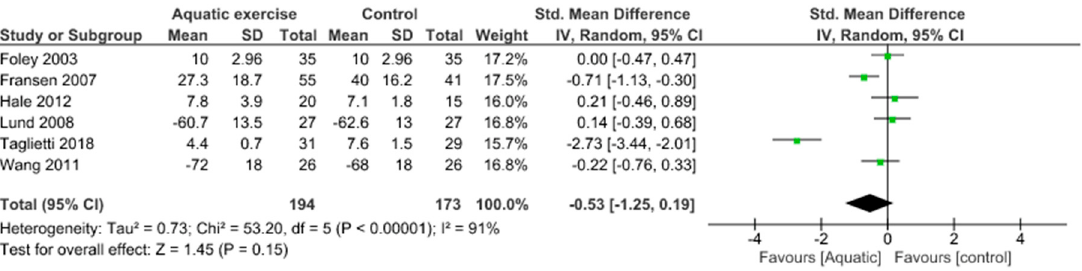
Figure 2. Pain: Aquatic exercise versus Land-based exercise.